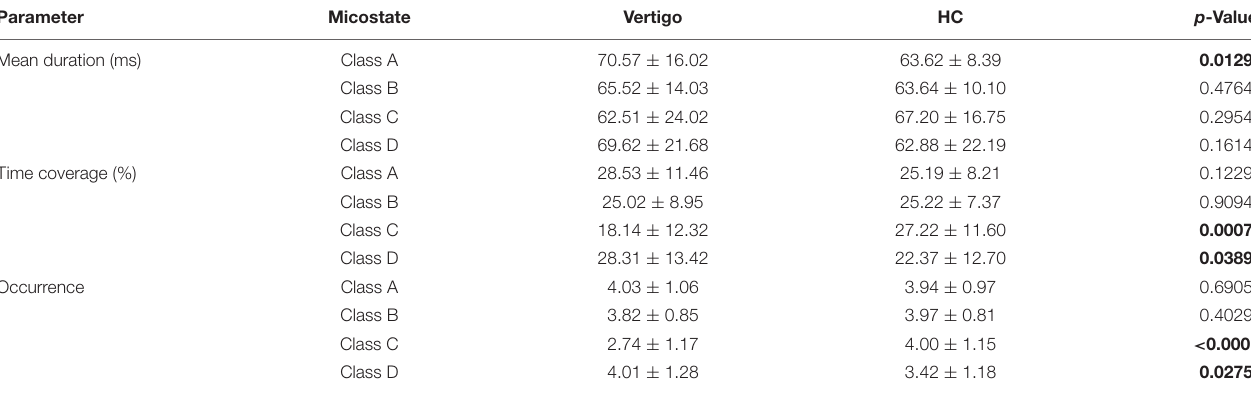
TABLE 2 | Patients with vertigo versus healthy controls for each microstate class. Parameter Micostate Vertigo HC p -Value